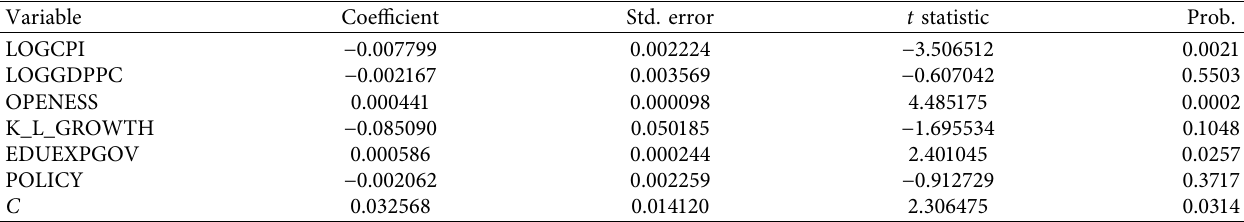
Table 7: Long-run coefficients: the dependent variable is the log of life expectancy at birth (years).